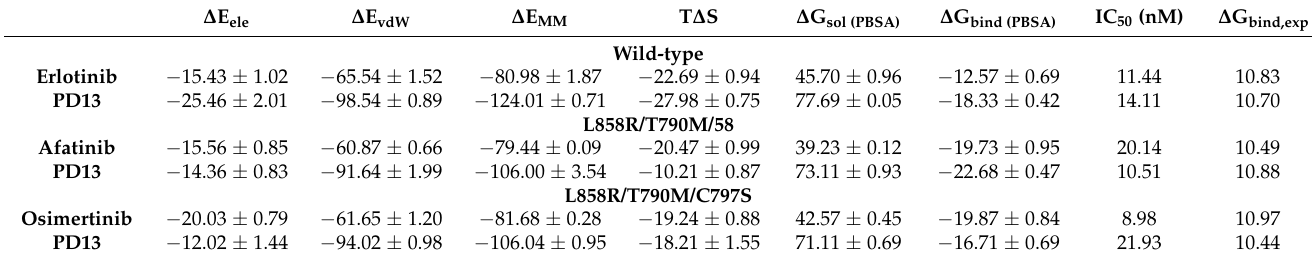
Table 4. The average ∆ G bind and its energy component (kcal/mol) of PD13 and drugs in com- plexes with EGFRs calculated with the MM/PBSA method, compared to the half-maximal inhibitory concentration (IC 50 ) values. Data are shown as mean ± standard deviation (SD) of three indepen- dent